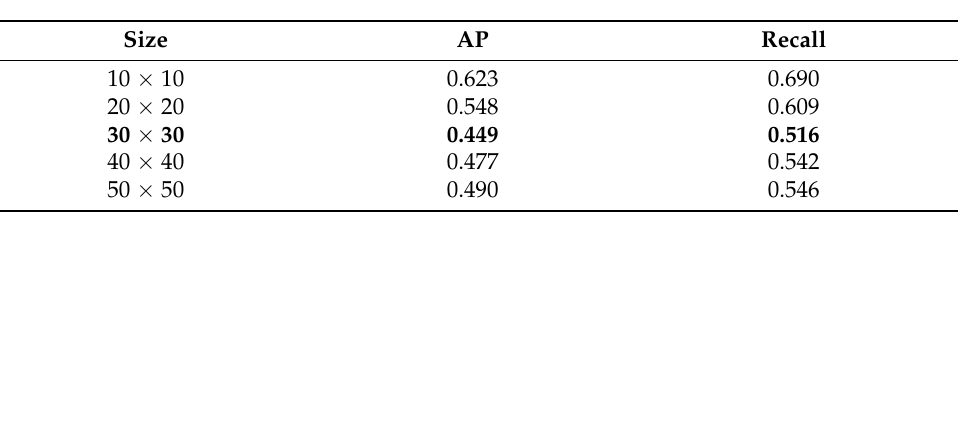
Table 6. Attack performance of our adversarial patches of different sizes. The evaluation metrics are AP and